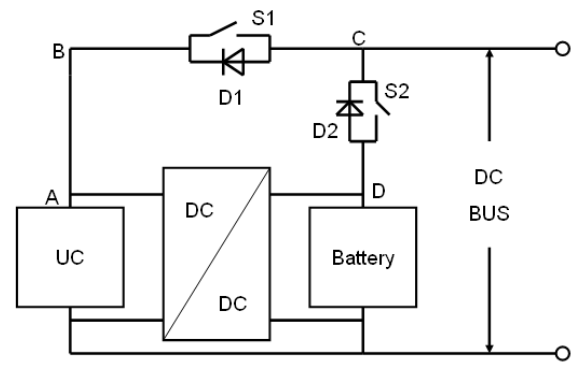
Figure 2. The configuration of the proposed HESS.